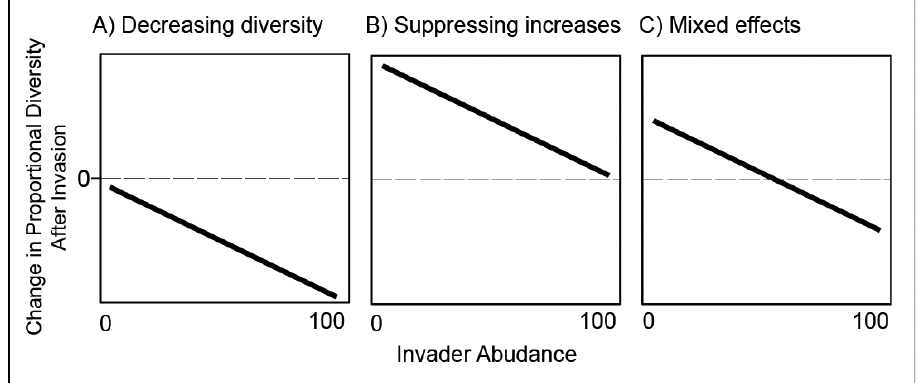
Figure 4 . Conceptual figure illustrating three possible ways invasive species abundance could negatively correlate with changes in diversity. A At high abundance, invaders could cause declines in diversity over time. B At low invader abundance, diversity increases through natural processes, but at high abundance, invaders prevent arrival of new species. C A combined model, where richness increases in the absence of invaders and invader presence above a threshold causes declines in diversity over time. Note that these hypothesised relationships may not be linear but may include threshold